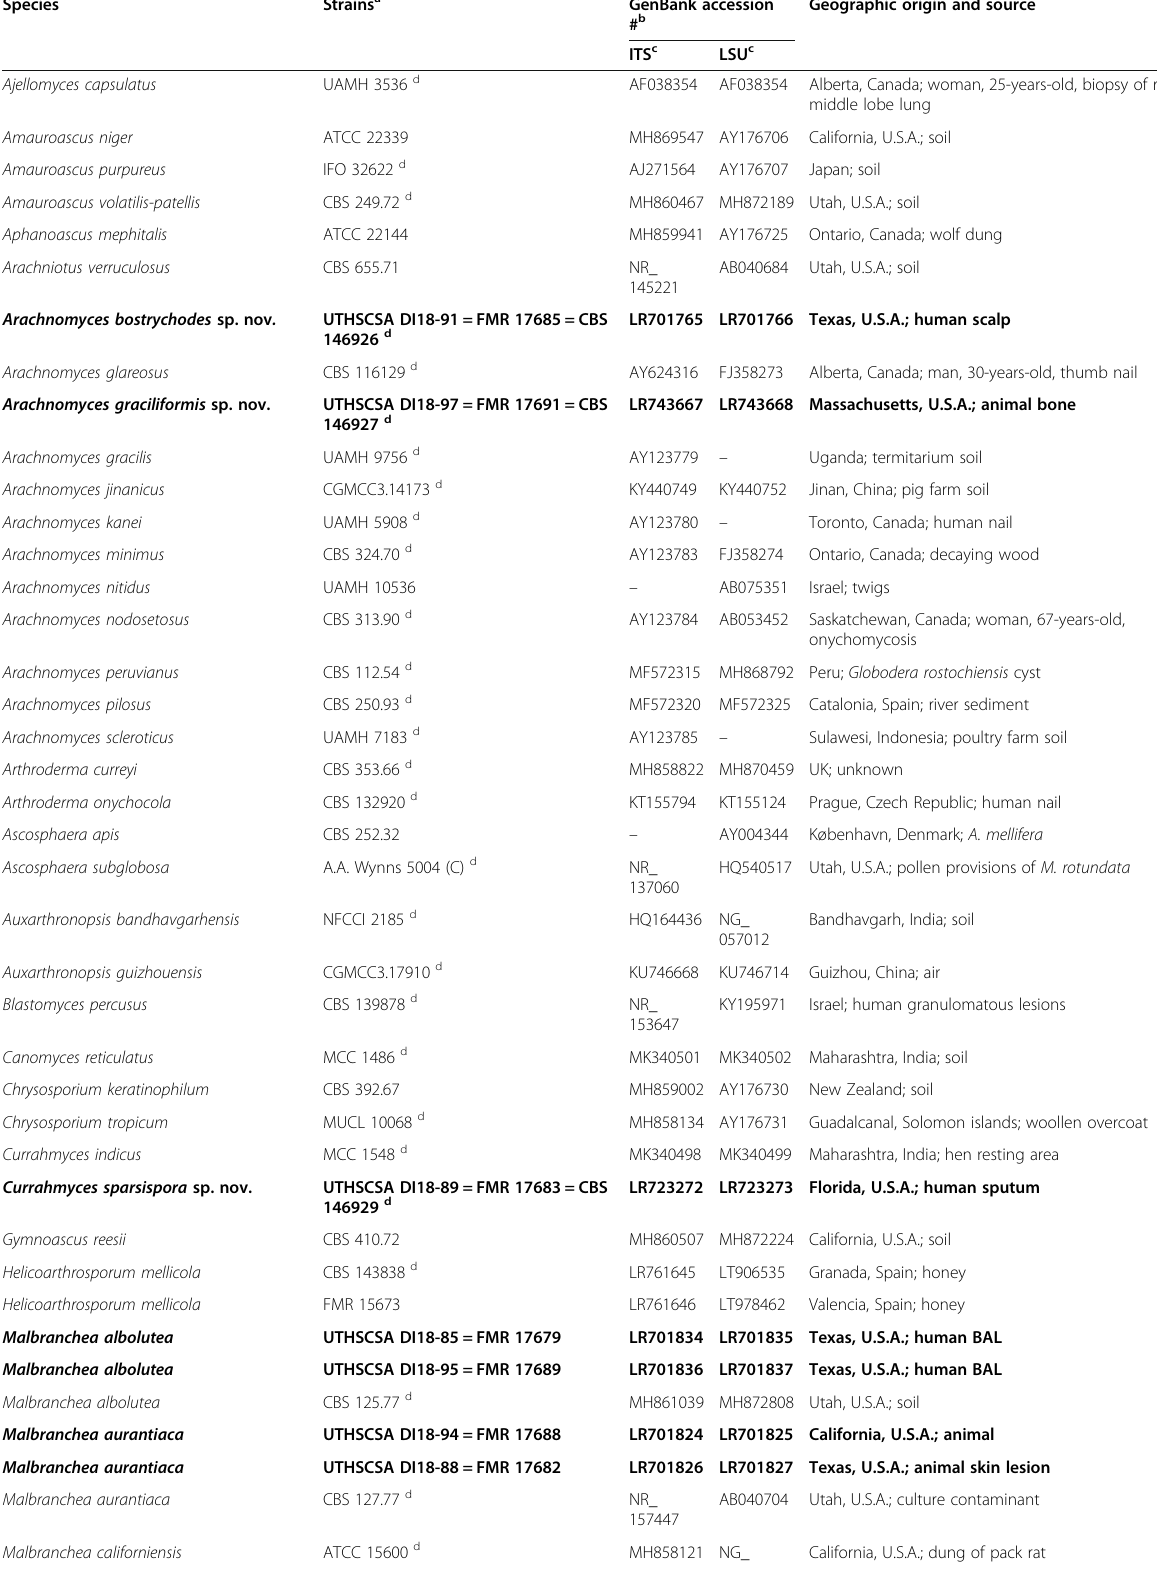
Table 1 DNA barcodes used to build the phylogenetic tree